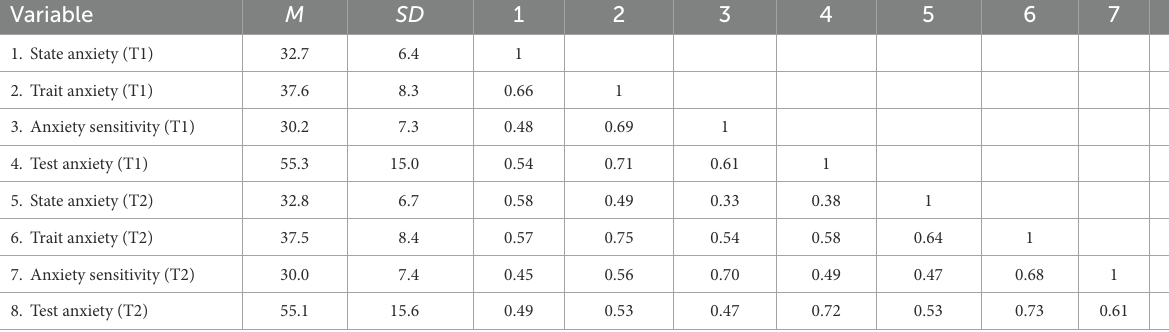
TABLE 2 Mean, standard deviations, and Pearson’s correlation coefficients between the four anxiety scores at T1 and T2. Variable